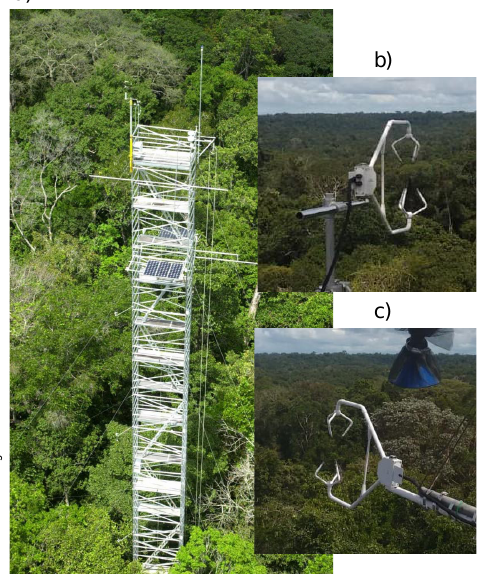
Figure 1. Some characteristics of the experimental site. ( a ) Micrometeorological tower located at Cuieiras reserve. ( b , c ) show 3-D sonic anemometer at 48 and 40 m above the ground. Source: http://lba2.inpa.gov.br/index.php/estacoes-de-pesquisa/zf-2-manaus/miss%C3%A3o-hist%